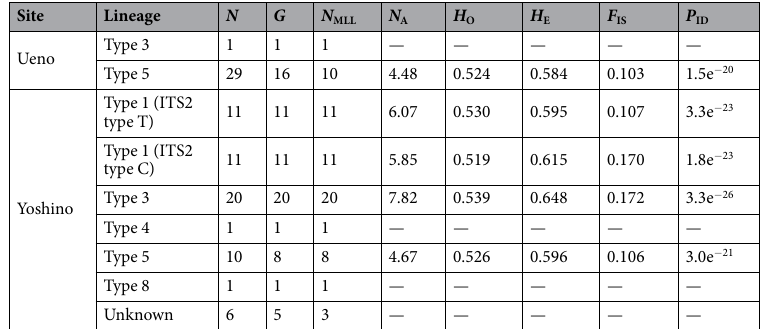
— — — — — — — — — Table 3. The number of samples ( N ), the number of multilocus genotypes ( G ), the number of multilocus lineages ( N MLL ), the mean number of alleles ( N A ), observed ( H O ) and expected ( H E ) heterozygosities, and the deviation index from Hardy-Weinberg equilibrium ( F IS ) across 27 loci for each lineage or site. The probability of identity ( P ID ) for 27 loci was determined with GenAlEx. For lineages or sites with low numbers of MLLs, N A , H O , H E , F IS , and P ID were not calculated in this table. Values of N A , H O , H E , and F IS for each locus are shown in Supplementary Table S1. PV7 was removed from this analysis because it was identical to